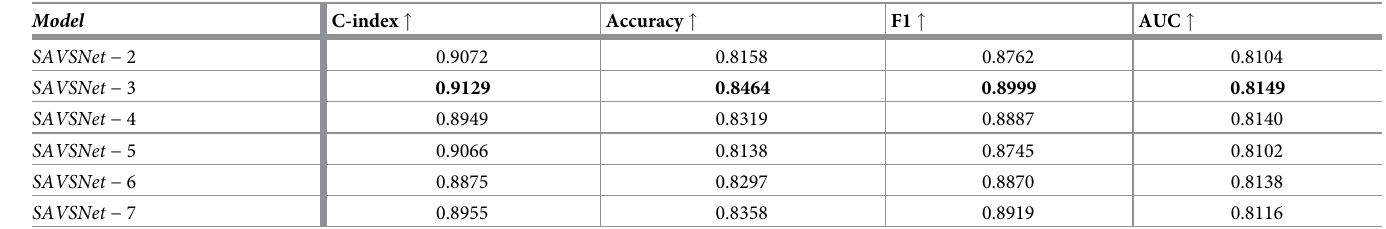
Table 6. The effect of different convolution kernel on KDDCup 2015.